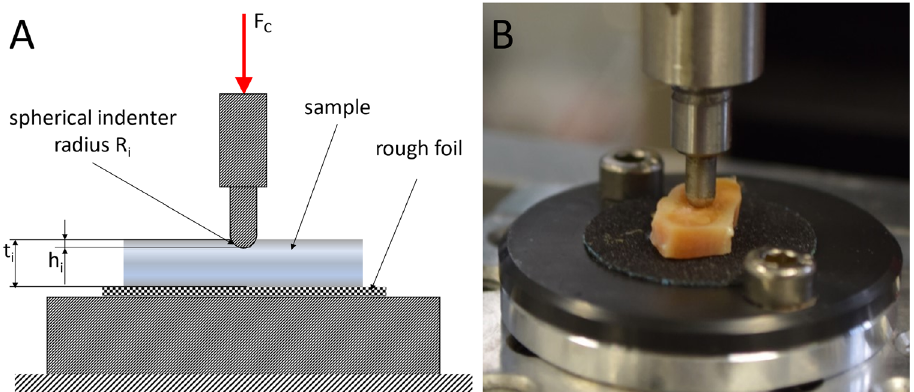
Figure 3. Experimental set-up of the indentation test. As indenter a custom made rigid spherical-tip (steel, radius R i = 1.5 mm) was used. The sample slices were centered below the indenter on a rigid plate. The surface of the plate was covered with a rough foil to prevent the samples from slipping. ( A ) Schematic test set-up. ( B ) Photographic test